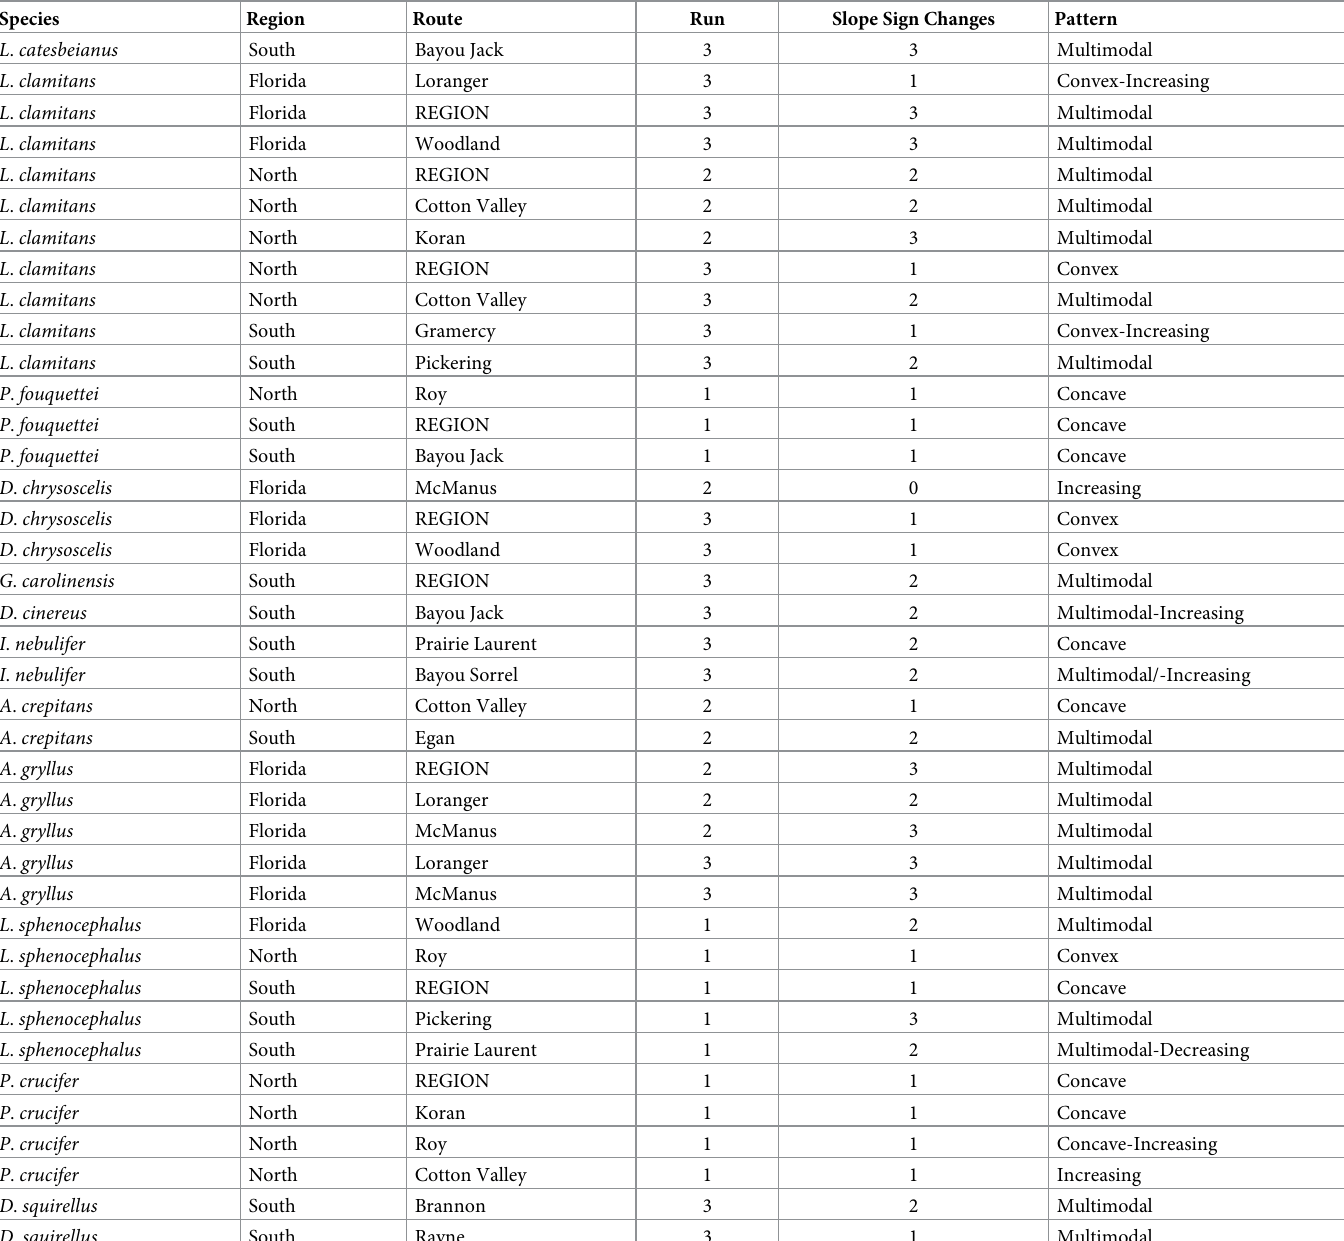
Table 11. Route-run and region-run species percent observation GAM